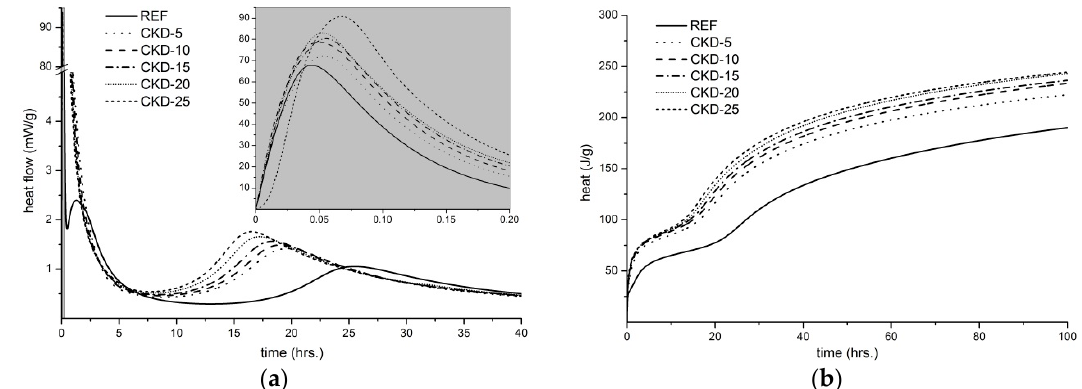
Figure 5. Evolution of heat flow ( a ) and total heat ( b ) of alkali-activated matrices with different amounts of CKD.